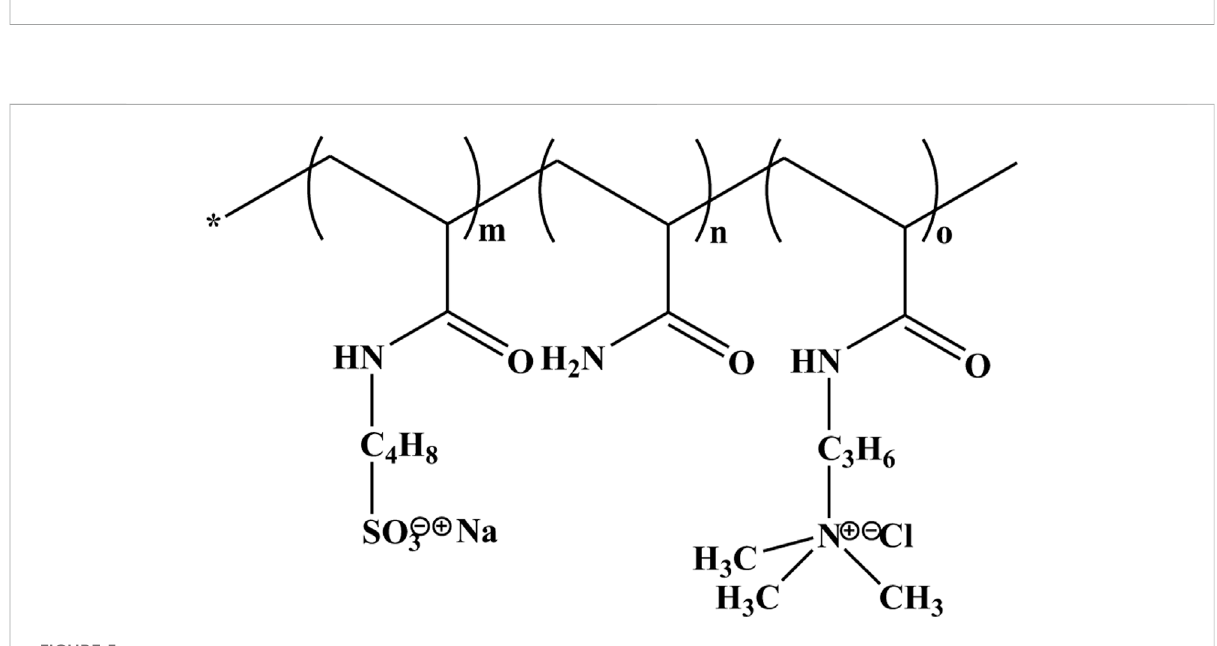
FIGURE 4 Schematic illustration of the chain extension of the BAP via the electrolyte and temperature